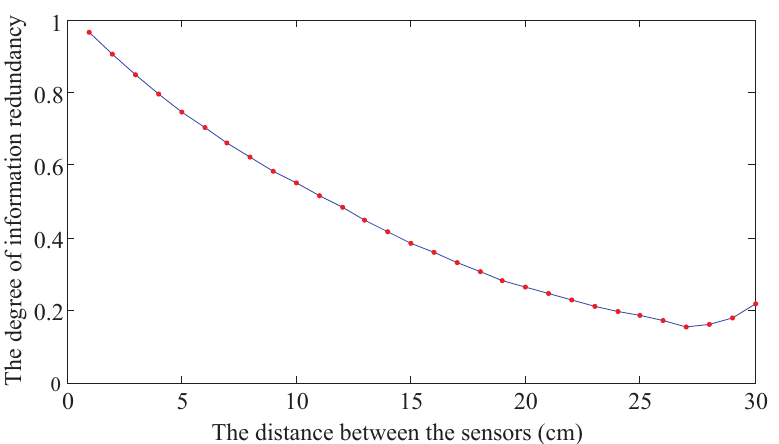
Figure 11. The relationship between information redundancy and the distance between